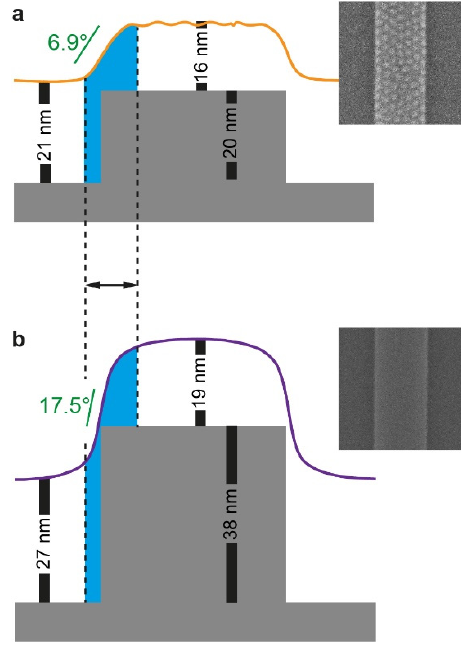
Figure 7. Schematic illustration demonstrating the correlation between the profile slope at the plat- eau edge and the pattern on the plateau. The blue shading highlights the zone of thickness frustration. The SFM film profiles (from Figure 6a) of 22–23 nm-thick films are overlaid on the schematics of the corresponding substrate featuring 640/640 nm trench/plateau widths with different trench depths: ( a ) 20 nm; ( b ) 38 nm. Height scale is exaggerated; the angular values of the steepest slopes at the plateau edges, calculated from the peak values in the curves in Figure 6b, are provided for reference. Insets show the corresponding patterns (Figure 2e,i).